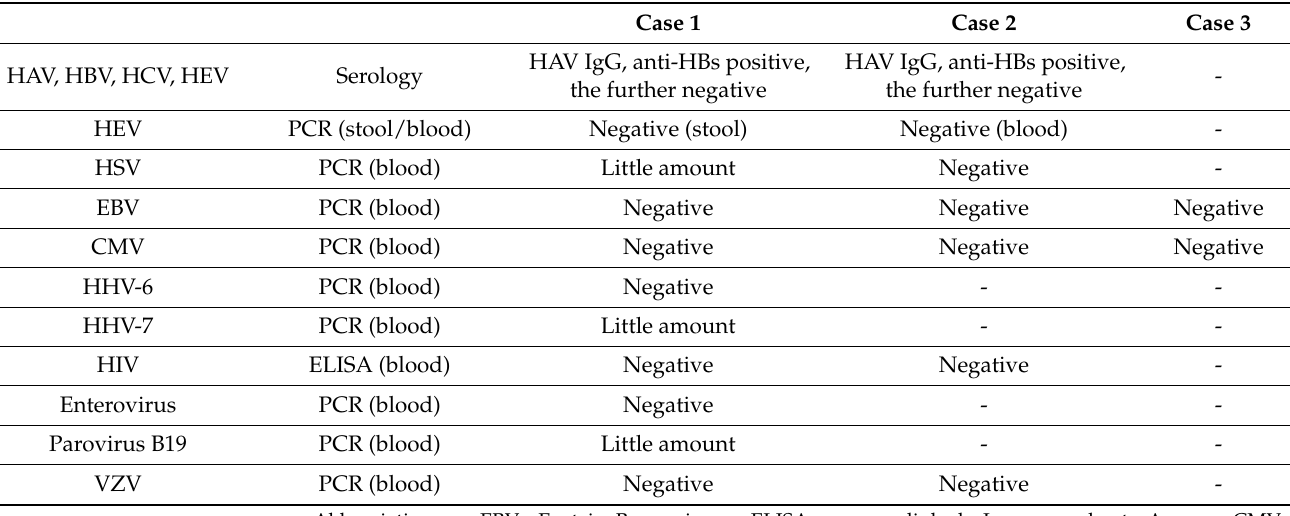
Table 3. Hepatitis—viral differential diagnoses.